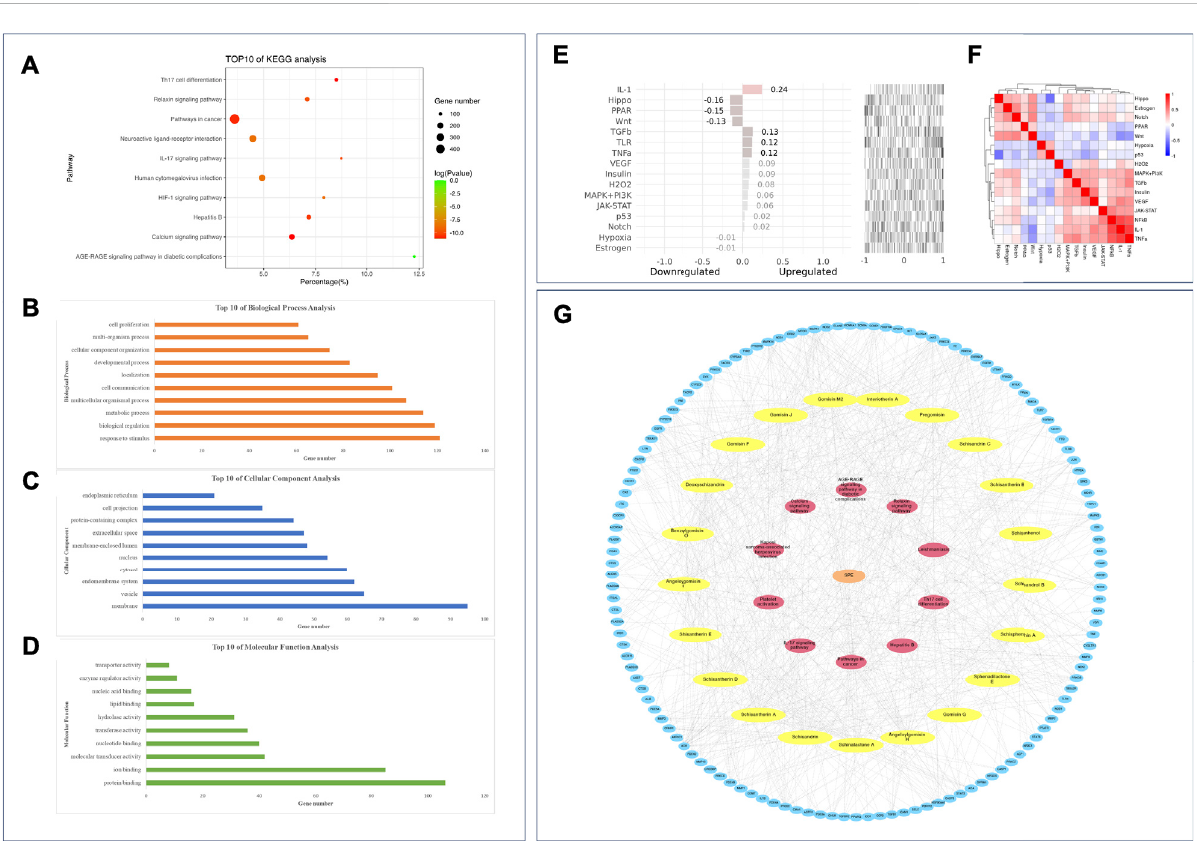
FIGURE 7 Enrichment analysis and network construction of the PEF against asthma. Top ten results of (A) KEGG analysis; (B) GO BP analysis; (C) GO CC analysis; (D) GO MF analysis. (E) Upstream pathway analysis of overlapping targets. (F) 16 pathways considered in upstream pathway analysis. (G) PEF – compound – target – pathway